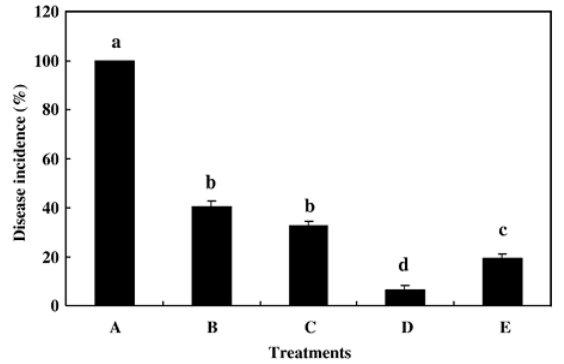
Figure 5. Efficacy of Cryptococcus laurentii (1 × 10 8 cells/mL) in inhibiting disease incidence of blue mold caused by Penicillium expansum in pear fruit wounds after 6 days of incubation at 25 °C in nutrient yeast dextrose broth (NYDB) ( B ), NYDB amended with chitin at 2.0% ( C ), 1.0% ( D ), 0.5% ( E ). The treatment with water and inoculated with P. expansum was served as the positive control ( A ). Bars represent standard errors. Different letters indicates significant differences ( P = 0.01) according to the Duncan’s multiple range test. Reproduced from Reference